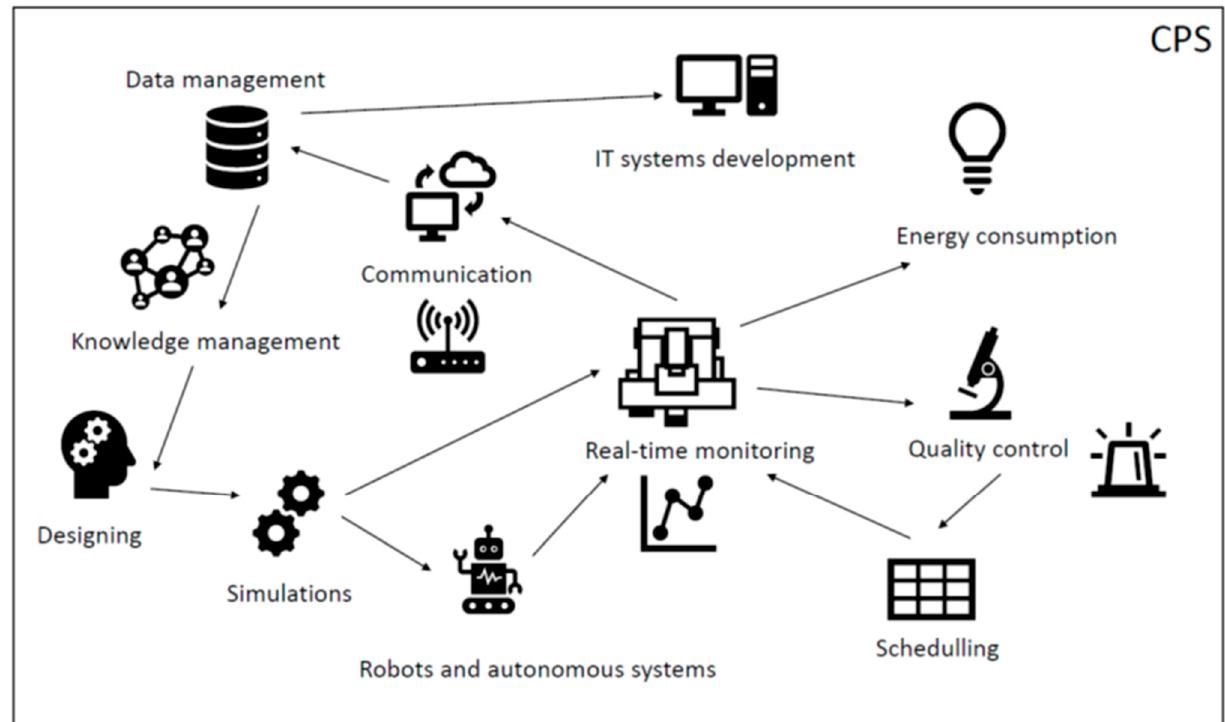
Figure 4. EC in CPS applications summary.